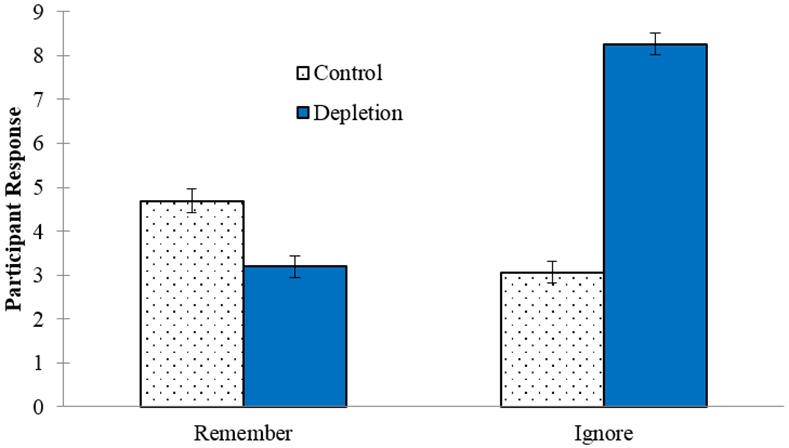
Condition differences in how hard participants reported they tried remembering and ignoring the words during the video task.Error bars represent SEM.